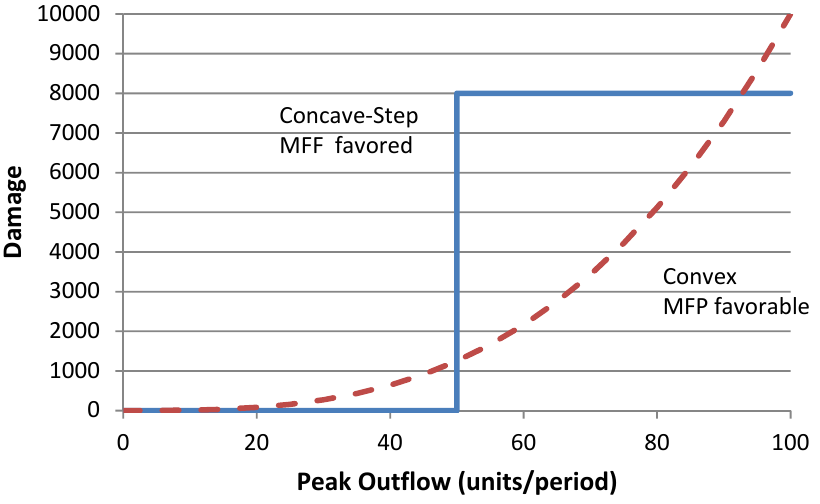
Figure 4. Damage curve shape affects operating rule